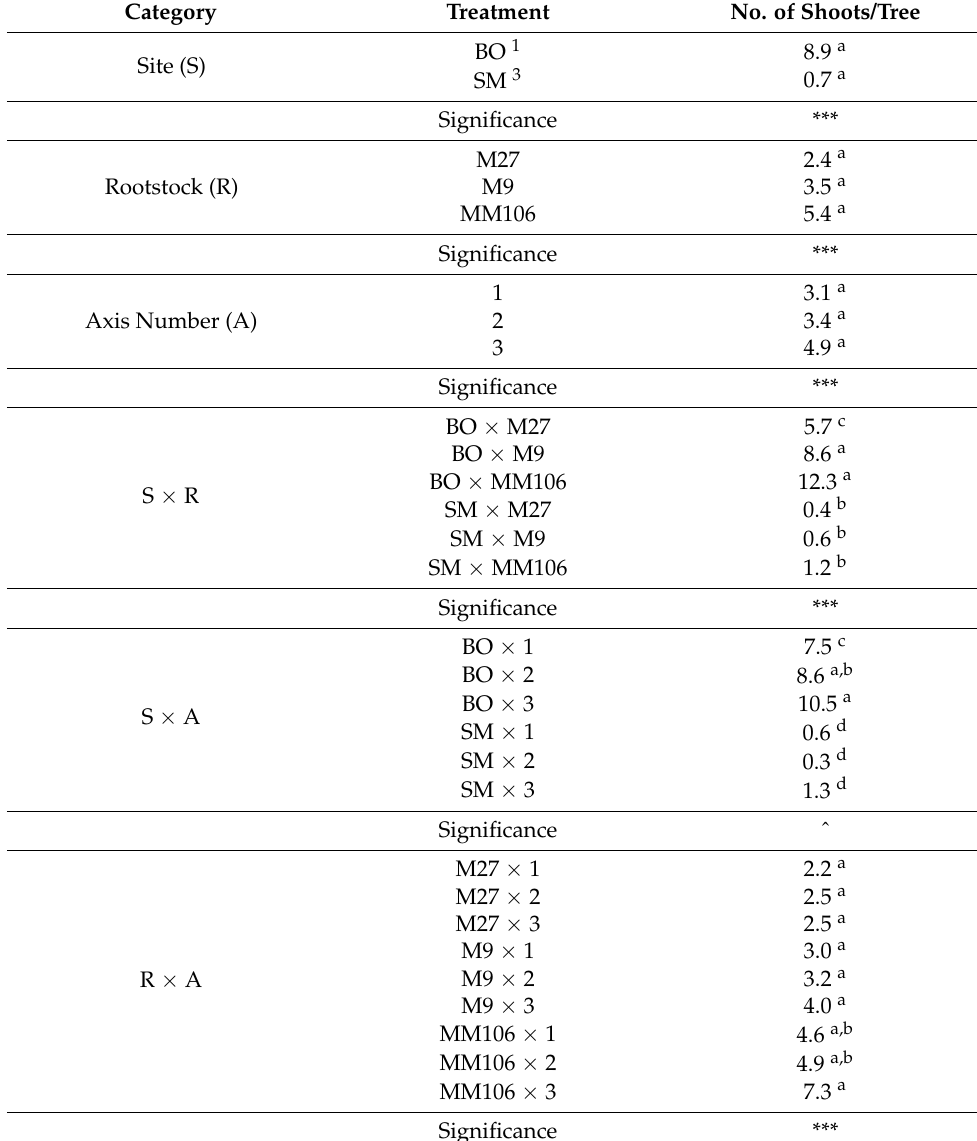
Table 6. Main effects of site of cultivation, rootstock, axis number, and their interactions on the number of second-order shoots developed in the first season after grafting in ‘Fuji’